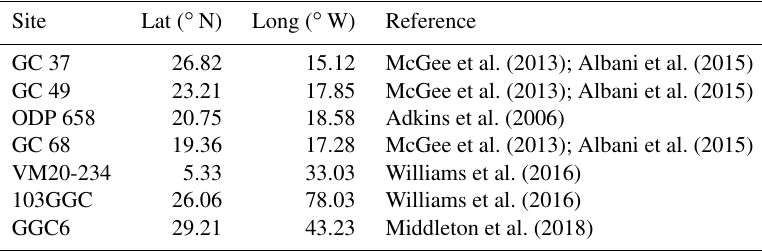
Table 1. Site locations and data references of marine sediment cores in the North